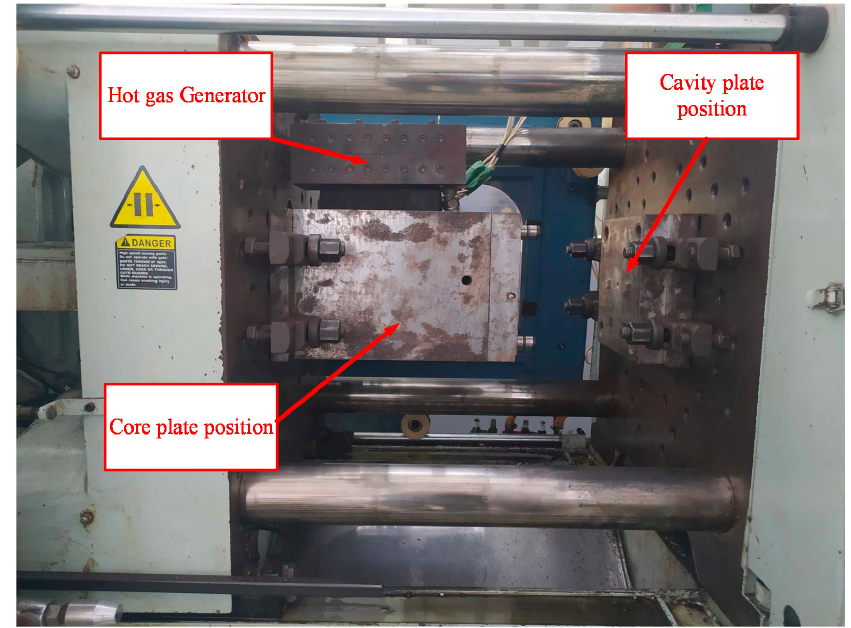
Figure 3. The experimental setup for In-GMTC.